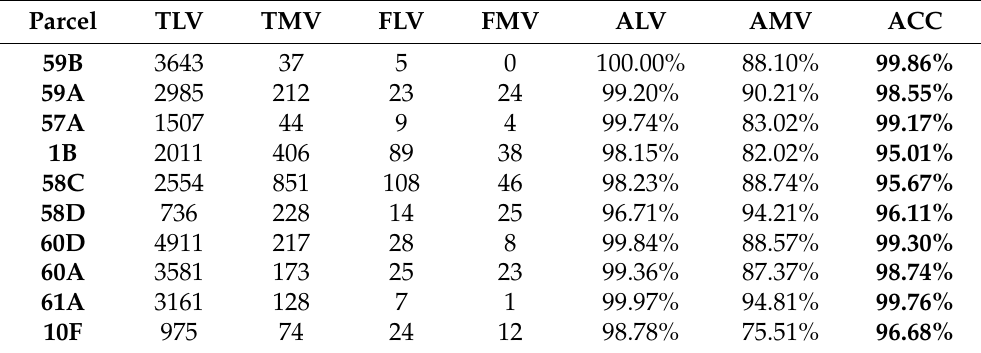
Table 3. Living and missing vine identification (Parcel 59B). Comparison between the obtained results and the on-screen vine